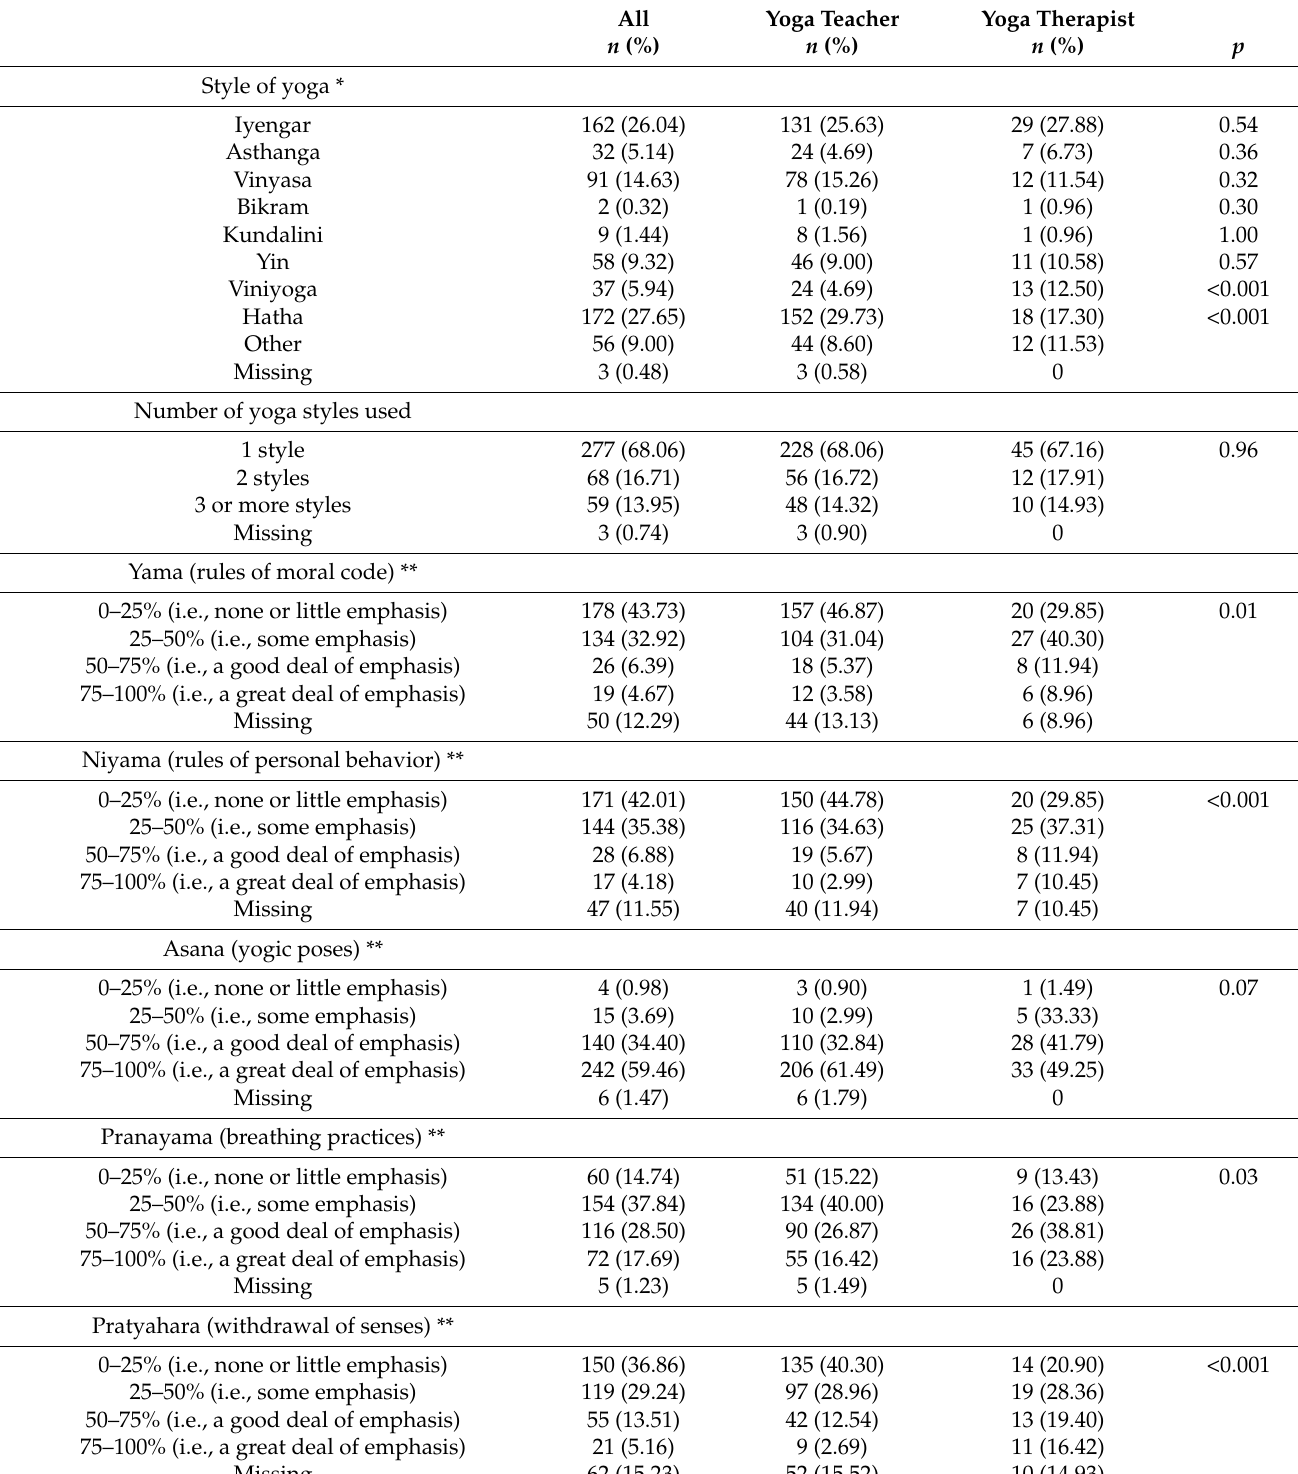
Table 3. Style and content of yoga